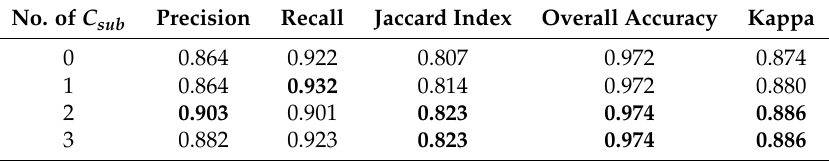
Table 6. Comparison of performance of MC–FCN models with variant numbers of subconstraints. The highest values for different metrics are highlighted in bold .